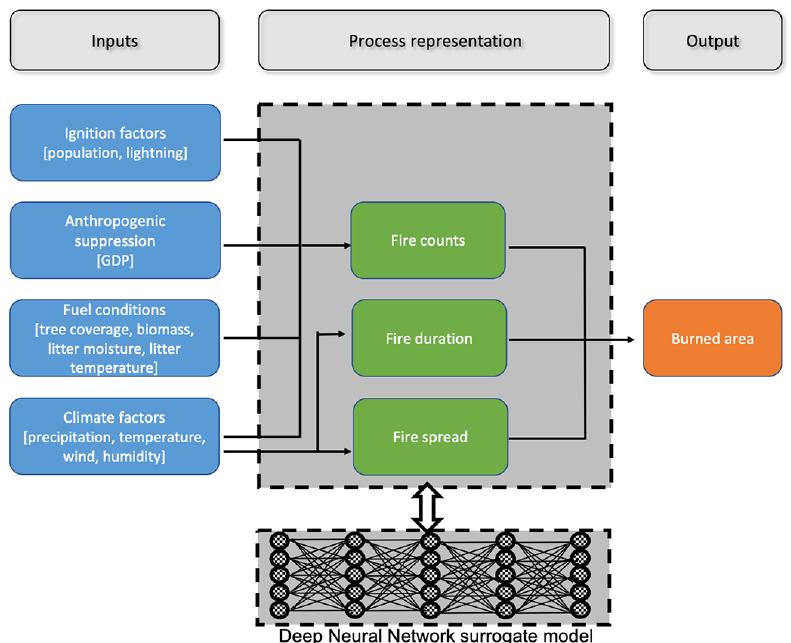
Figure 1. Schematic representation of the ELMv1 process-based BASE-Fire model and the components to be surrogated with the deep neural network (DNN) model (dark